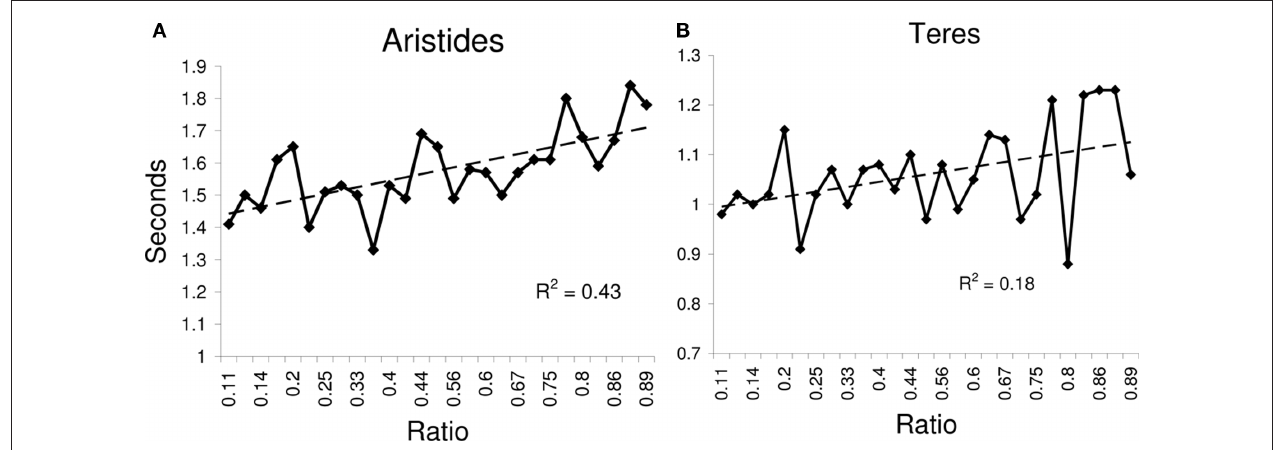
Figure 9 | response time for experiment 2B as a function of the numerical ratio between the values being compared for (A) Aristides, and for (B)